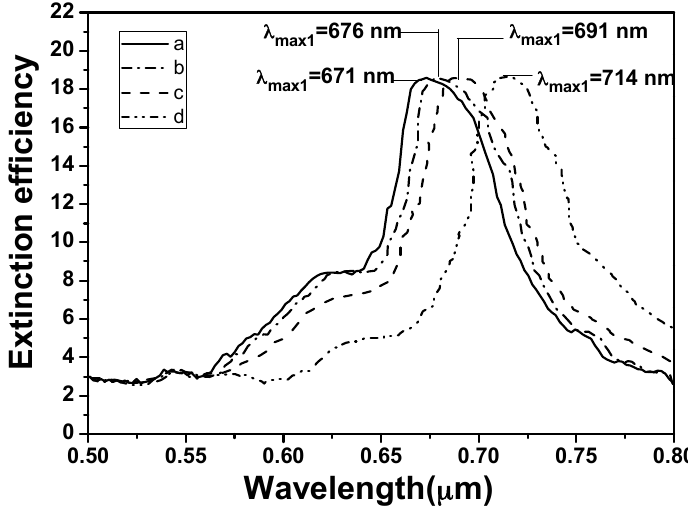
Figure 11. LSPR spectra of each step: ( a ) the hybrid Au–Ag hexagonal lattice of triangular PNAs; ( b ) the hybrid Au–Ag hexagonal lattice of triangular PNAs modified with the modification of SH- β -CD without dipping PCB-77; and the hybrid Au–Ag hexagonal lattice of triangular PNAs ( c ) without modification of SH- β -CD and ( d ) with the modification of SH- β -CD to measure the PCB-77 of 1 × 10 − 5 g/mL.